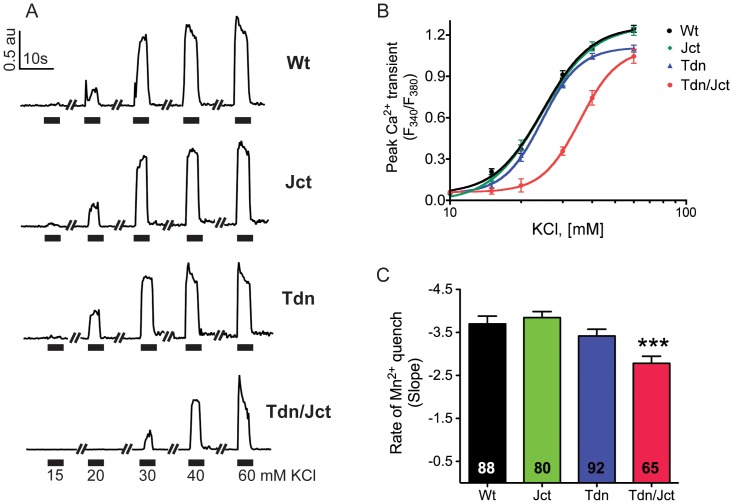
Effect of Tdn and Jct on e-c coupling and ECCE.A) Representative traces of K+ -dose responses of primary cultured myotubes from wild type (WT), triadin-null (Tdn), junctin-null (Jct) and triadin/juctin double-null (Tdn/Jct) mouse muscles. B) Average peak fluorescent amplitude of depolarization-induced Ca2+ release response of WT (black, n = 114 cells), Jct-null (green, n = 83 cells), Tdn-null (blue, n = 57 cells) and Tdn-/Jct null (red, n = 68 cells) myotubes. Myotubes were loaded with 5 µM Fura-4F and exposed to increased concentrations of K+ for 5 s. C) Average rate of decrease in Fura-2 signal by Mn2+ quench during depolarization with 80 mM KCl. Numbers in the bars indicate the number of cells analyzed per condition. The data are from 3–4 experiments and are presented as mean ± SEM (***p<0.001 (ANOVA, One-way analysis of variance, Tukey's multiple comparison test)).